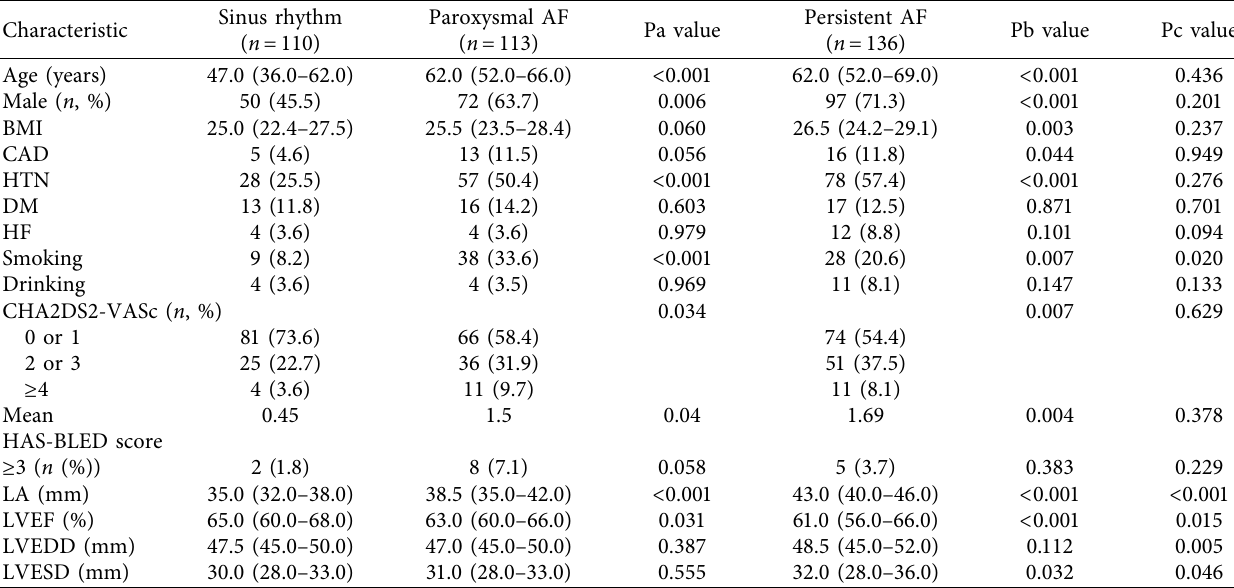
Table 1: Baseline clinical